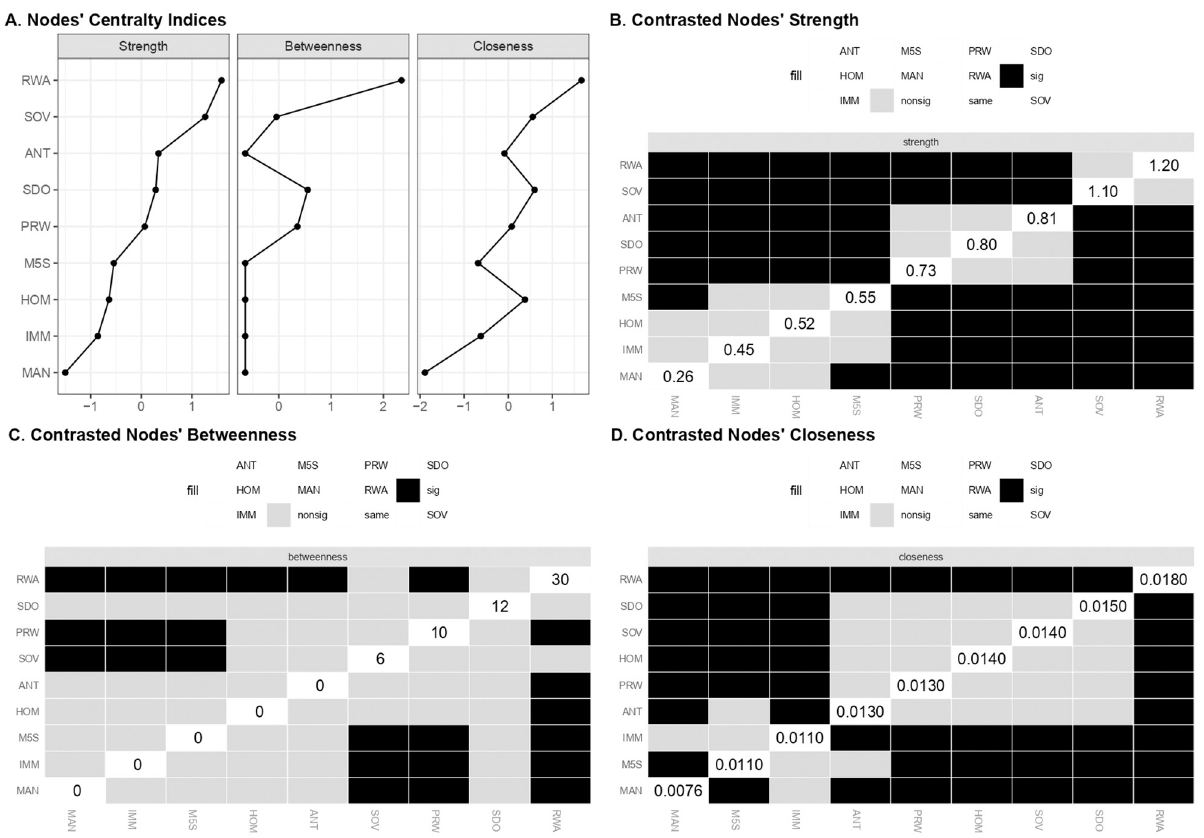
Fig 10. Estimates and bootstrap differences of centrality indices of the integrated beliefs system network. (A) Standardized values of centrality indices for each node of the network. (B) Bootstrap differences between nodes for the strength centrality index. (C) Bootstrap differences between nodes for the betweenness centrality index. (D) Bootstrap differences between nodes for the closeness centrality index. Fig 10B-10D report sample estimates on the diagonal, while bootstrap differences in the black and gray boxes. Black boxes indicate significant differences based on bootstrap mean estimates.